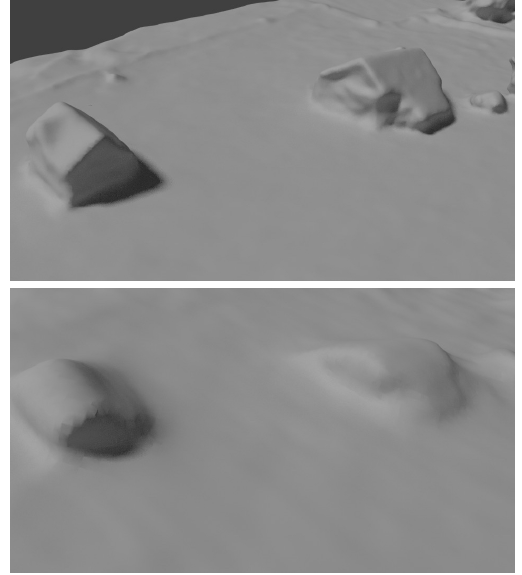
Figure 6. Scene 3D model created using color and thermal images